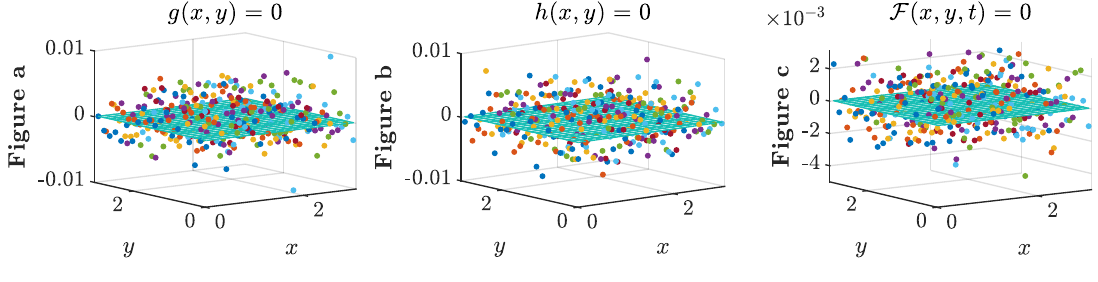
Figure 1. The exact data g ( x , y ) = h ( x , y ) = F ( x , y , t ) and their observation value at time t = 1/4.